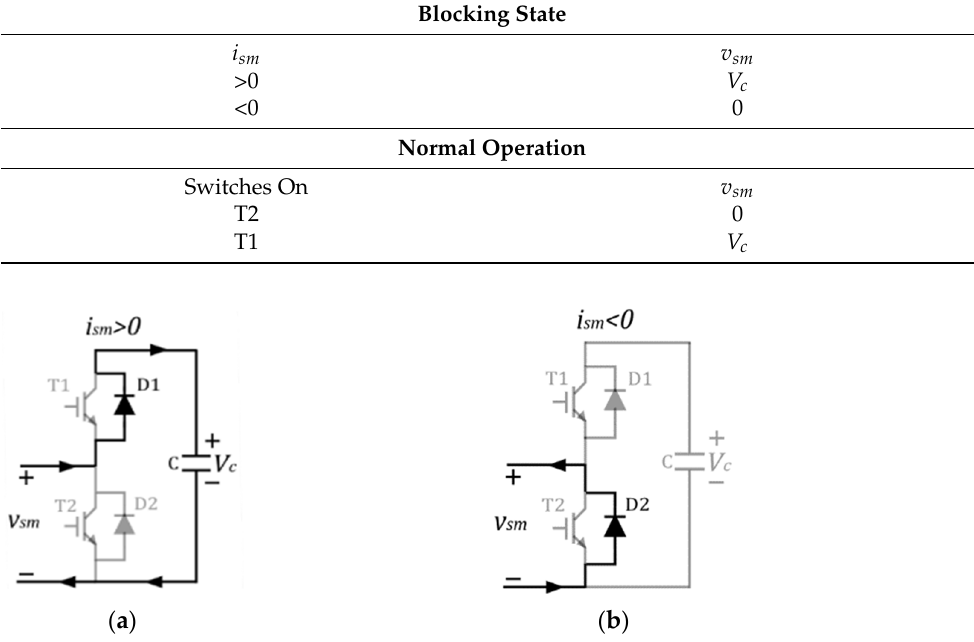
Figure 2. Fault current path: ( a ) HBSM for i sm > 0; ( b ) HBSM for i sm < 0. Table 2. FBSM Switching States.